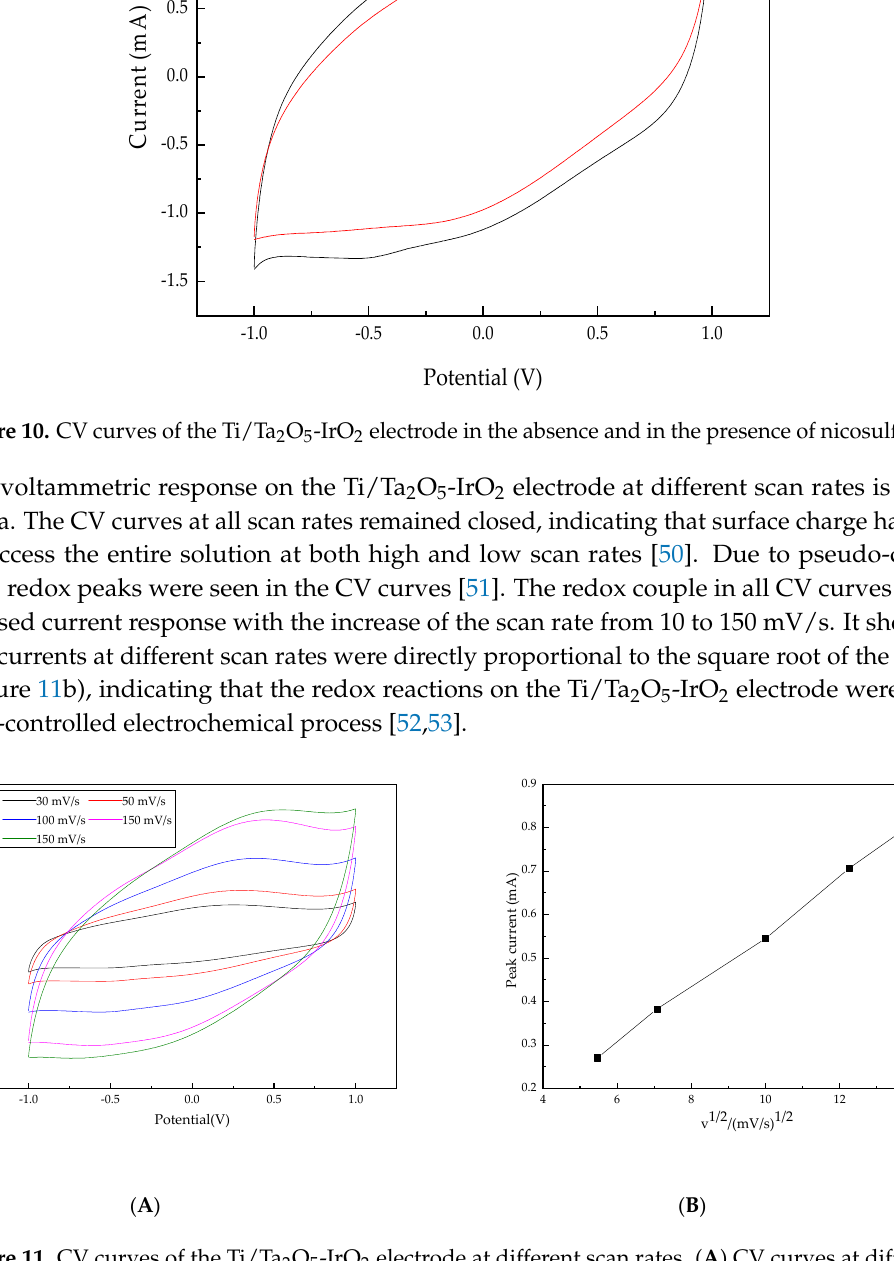
Figure 12. Electrospray ionization source (ESI) spectrum from 6.217 min to 6.367 min.